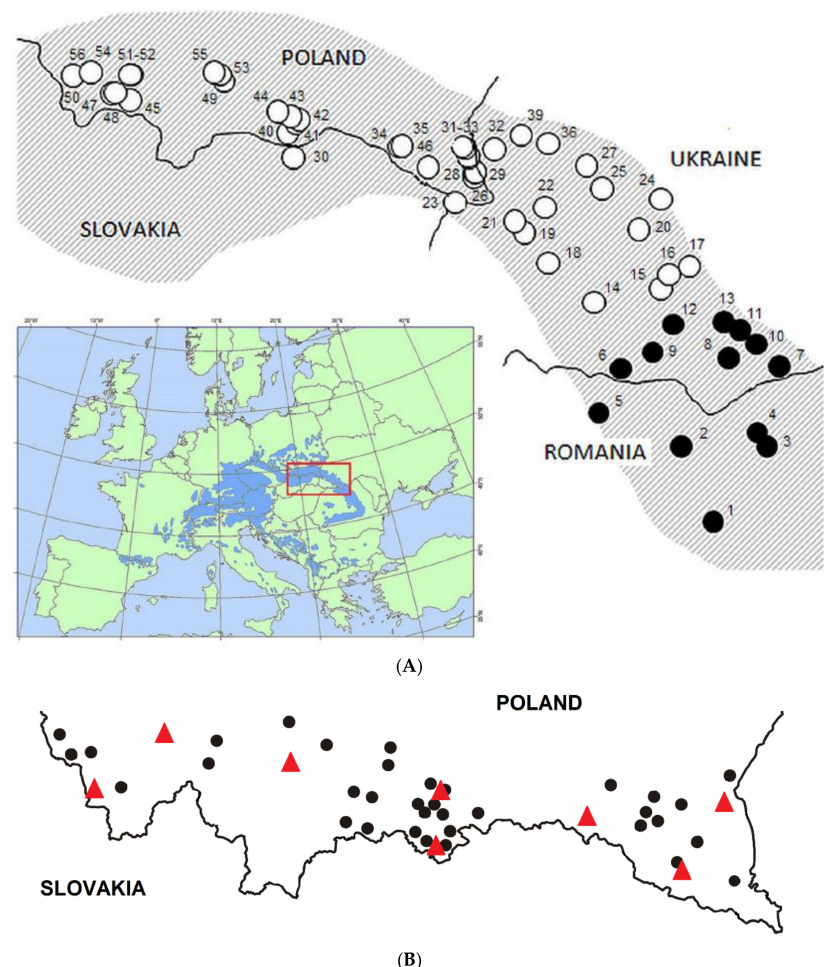
Figure 1. Study sites representing the two maternal lineages originating from the western (white dots) and eastern (black dots) refugial regions within the present distribution (grey background) of Abies alba (EUFORGEN 2009, www.euforgen.org) ( A ) and location of the provenances (black dots) and test sites (red triangles) in the provenance trial in the Polish Carpathians ( B